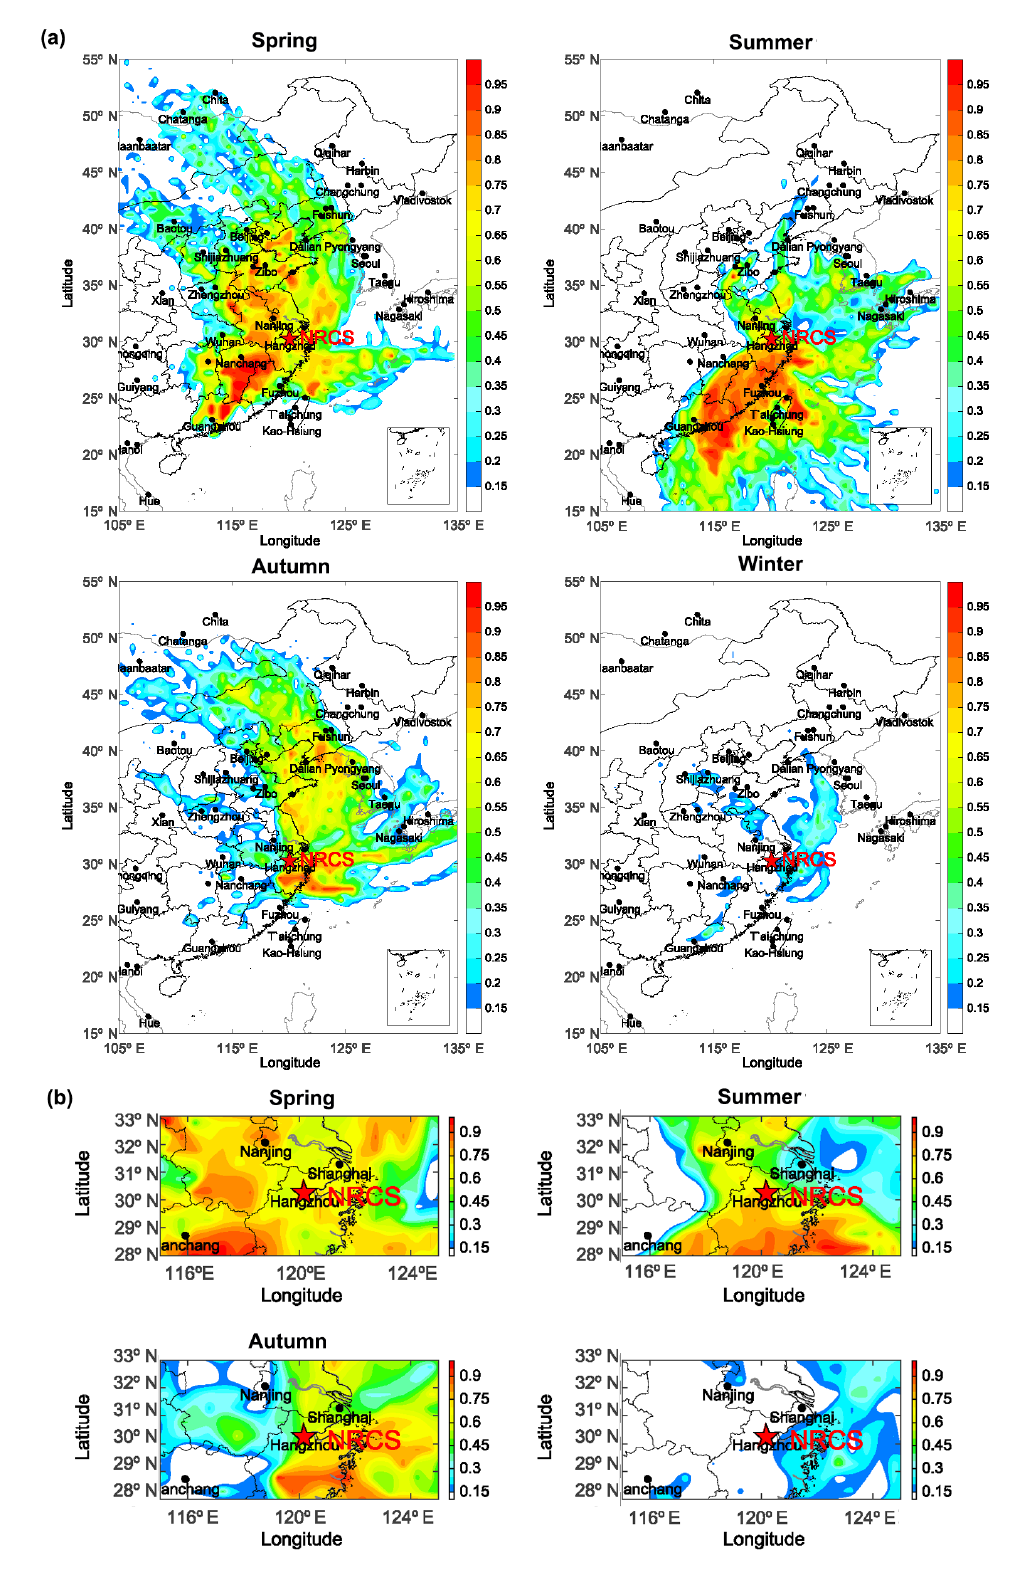
Figure 7. (a) Same as Fig. 6a but for O 3 . (b) The zoomed view of Fig.